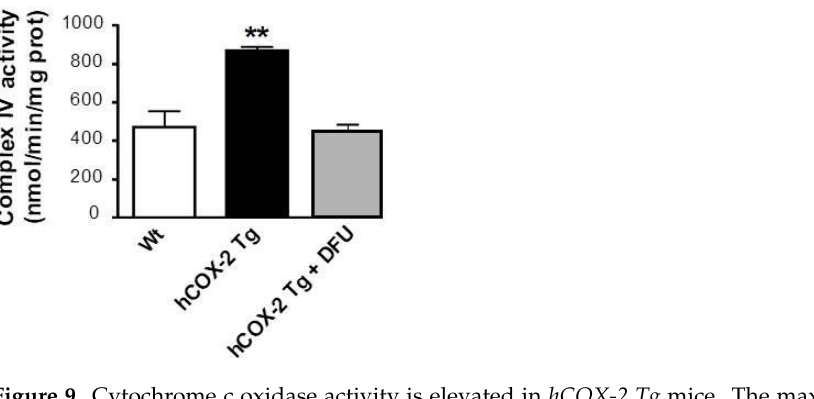
Figure 9. Cytochrome c oxidase activity is elevated in hCOX-2 Tg mice. The maximal activity of complex IV was measured in heart lysates Wt ( n = 9), hCOX-2 Tg ( n = 9), and hCOX-2 Tg mice treated with the COX-2 inhibitor DFU ( hCOX-2 Tg +DFU, n = 9). Data represent the mean values ± SD; ** p < 0.01 hCOX-2 Tg mice vs. Wt or hCOX-Tg +DFU animals.